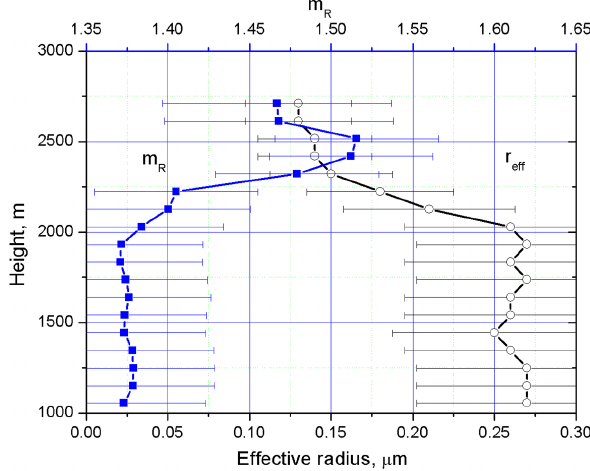
Figure 11. Extinction Ångström exponent (EAE) and lidar ratios at 355 and 532nm on 1 July 2014.